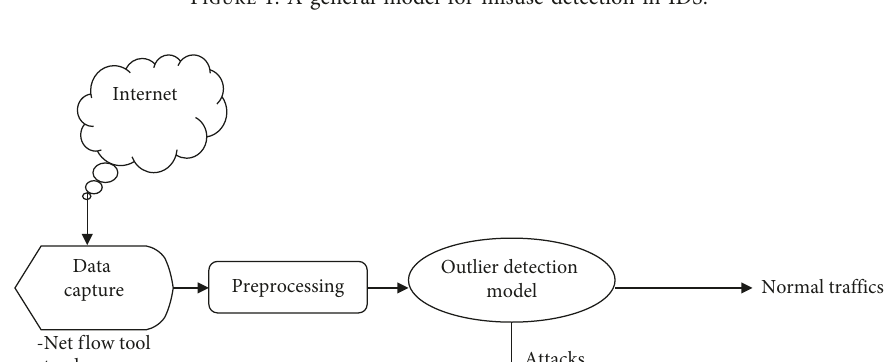
Figure 1: A general model for misuse detection in IDS.